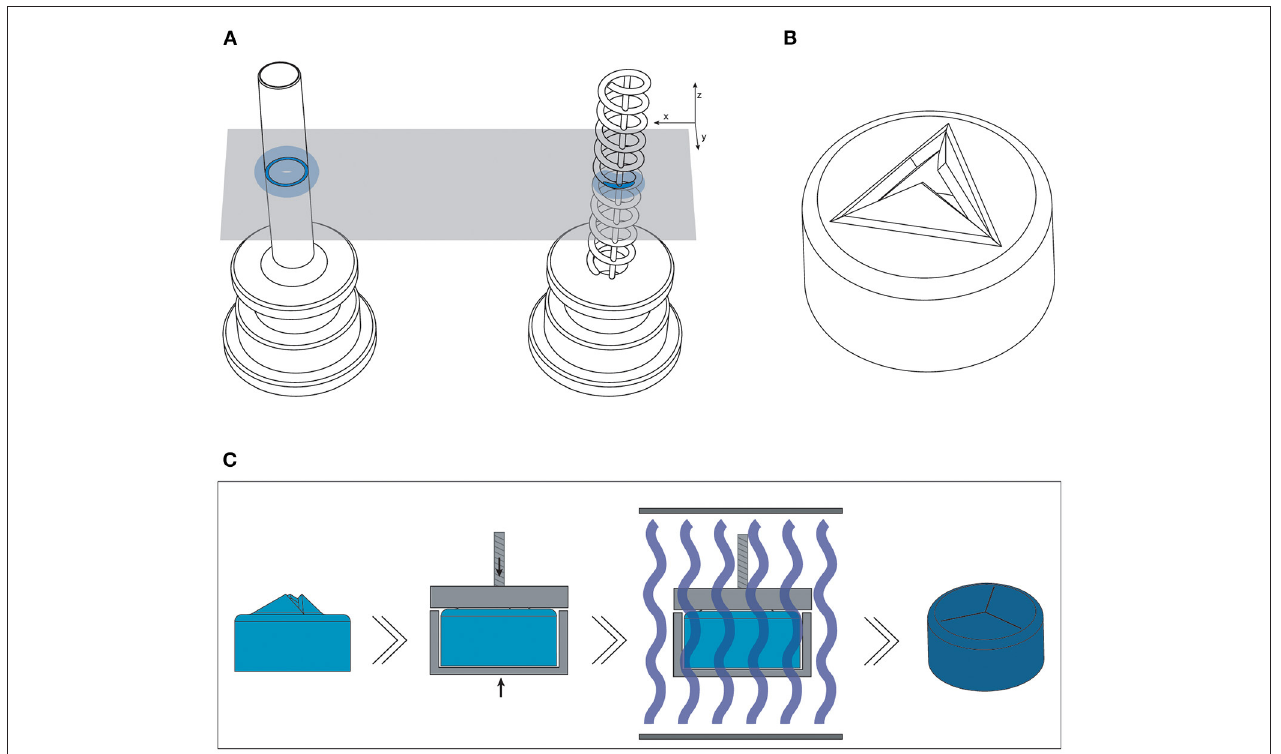
FIGURE 5 | Overview of the optimized design and method for printing the trocars. (A) The new helix design (right) of the cannula, which has a smaller surface area (dark blue) per layer than the previous cannula (left), and should therefore be less hindered by the effects of false printing (light blue). (B) 3D model of the valve, in which the valve flaps are modeled to point upwards in order to create more negative space around them. (C) New production process steps for the valves: after printing and cleaning, the valves are placed in a clamp which presses the flaps down; the entire clamp and valve are subsequently